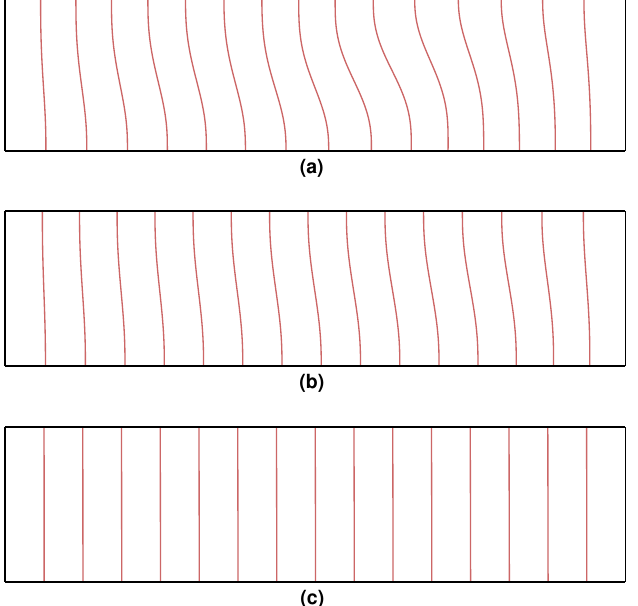
Figure 8. Isotherms for the two-dimensional buoyancy-driven flow problem at Gr = 2 × 10 4 , Ra = 2 × 10 2 . ( a ) Ha = 1; ( b ) Ha = 10; ( c ) Ha =